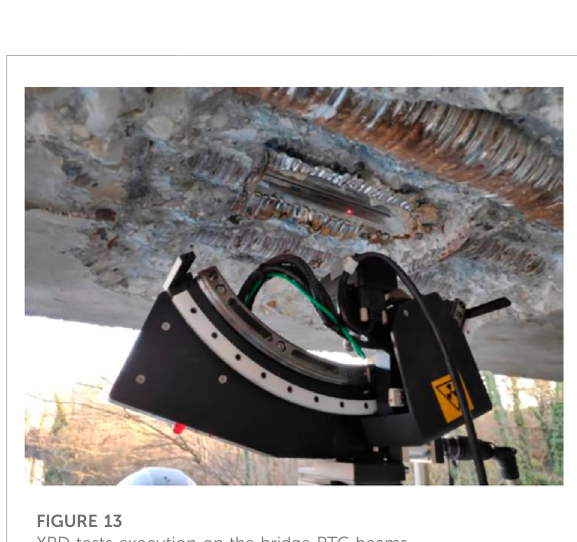
FIGURE 13 XRD tests execution on the bridge PTC